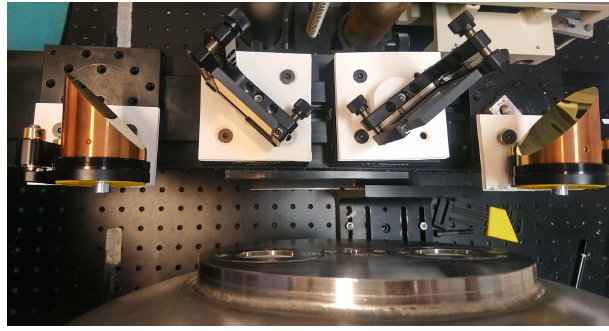
Figure 4. The transfer optics for the FTIR are shown.